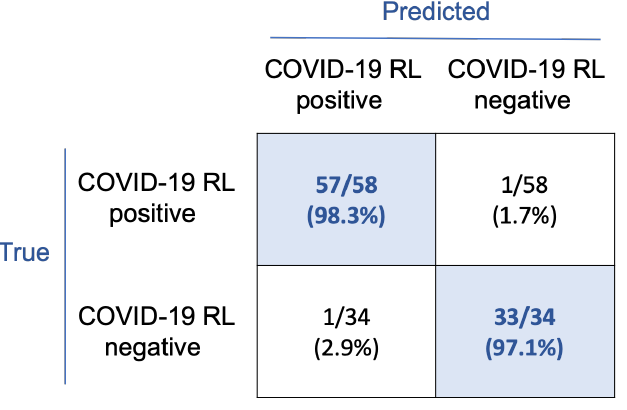
Figure 7. Confusion matrix for the classification of the 92 smears from the infected patients under study. Target groups are COVID-19 RL-positive and COVID-19 RL-negative. Results are expressed in absolute values and in